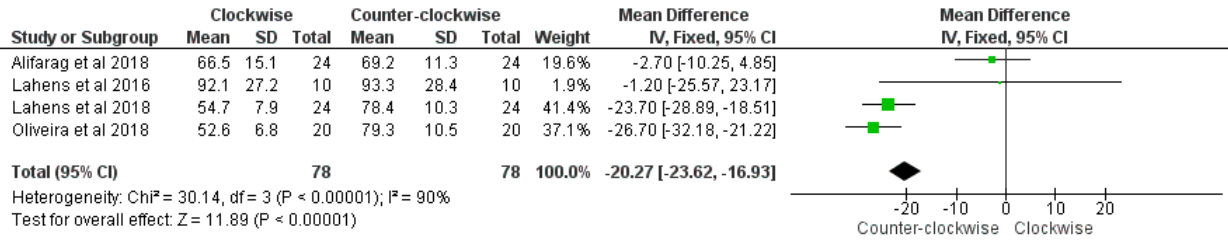
Figure 13. Forest plot of comparison of insertion torque, of the clockwise procedure (right) and counter-clockwise procedure (left).